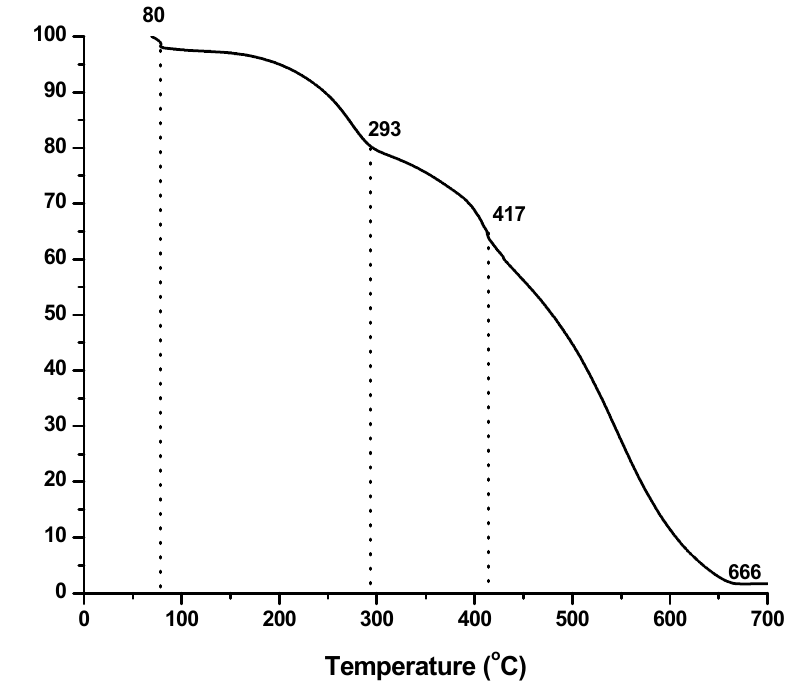
Figure 17. TGA curve of PANI salt.